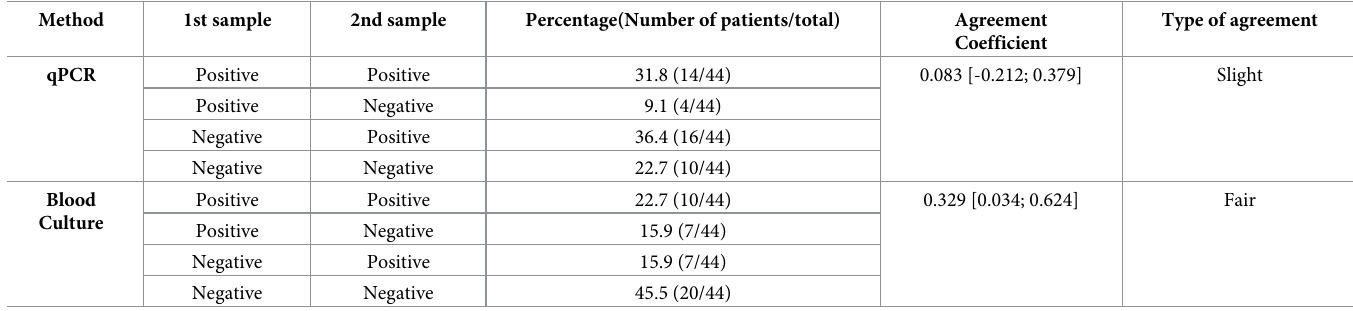
Table 3. Percentage of concordance, point and interval estimates of kappa coefficient according to qPCR and blood culture methods in 44 Chagas disease patients with two blood harvesting.